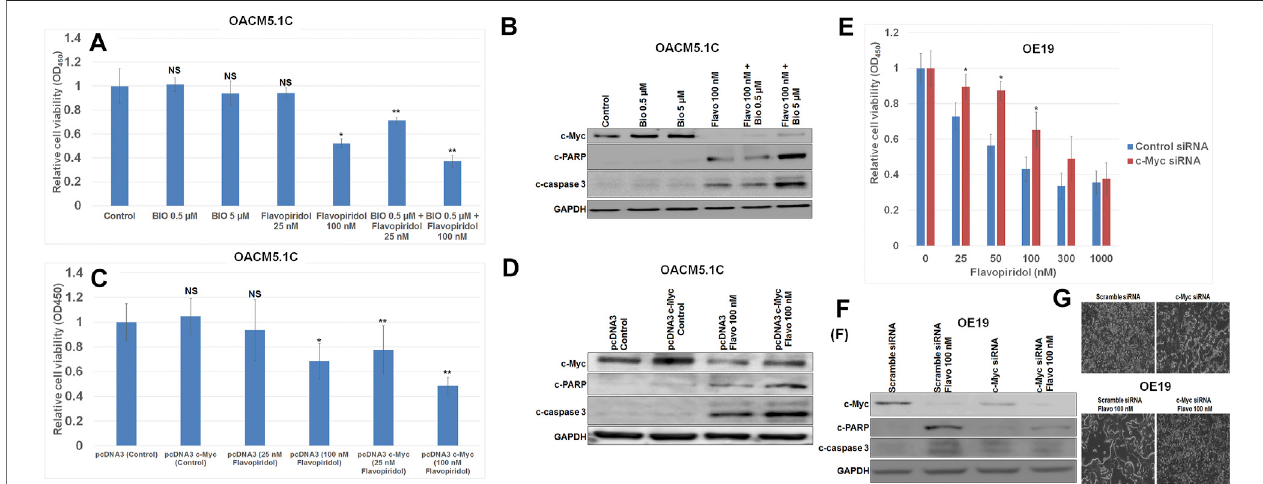
FIGURE 2 | c-Myc overexpression enhanced and c-Myc knockdown diminished fl avopiridol induced EC cell death . (A,B) Elevated c-Myc expressions either chemically by 6-Bromoindirubin-3 ˊ -oxime (BIO) or (C,D) genetically by pcDNA3 c-Myc made OACM5.1C cells more sensitive to fl avopiridol induced cell death as determined by (A and C) WST-1 cell proliferation assay or by (B,D) Western blot analysis compared to those of parent OACM5.1C cells. (E,F) Knockdown of c-Myc expressionsbyc-MycsiRNAmadeOE19cellslesssensitiveto fl avopiridolinducedcelldeathasdeterminedby (E) WST-1cellproliferationassayorby (F) Western blot analysis compared to those of parent OE19 cells. (G) Microscopic picture showing attenuated antiproliferative effect of fl avopiridol (Flavo 100 nM) in c-Myc siRNA OE19 cells after knockdown of c-Myc by c-Myc siRNA. In WST-1 assays (A,C,E) data are the mean ± SDE of six determinations. In fi gure (A) and (C) *